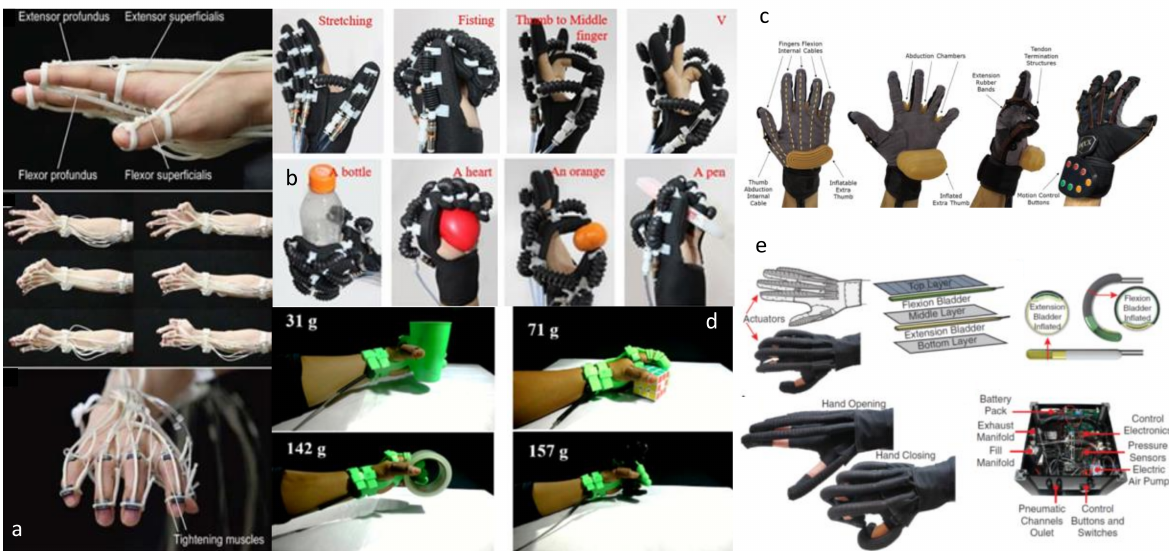
Figure 22. Soft gloves for Rehabilitation and for Assistance. ( a ) The thin McKibben-based soft glove developed by Takahashi et al. [61]. Reprinted/adapted with permission from Ref. [61].